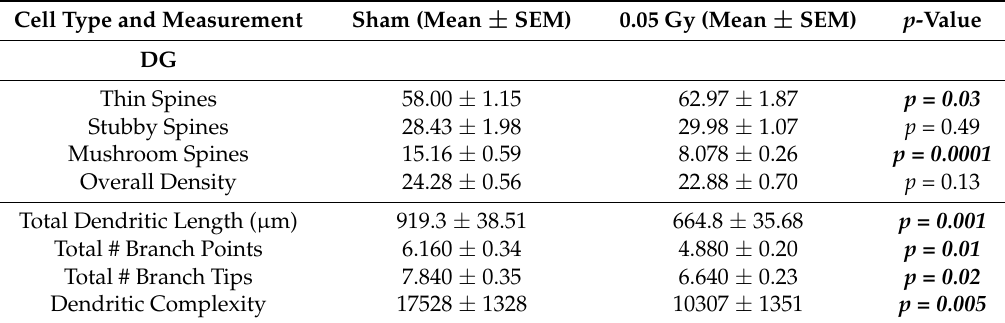
Table 1. Effects of 16 O on dendrite morphology in the DG.